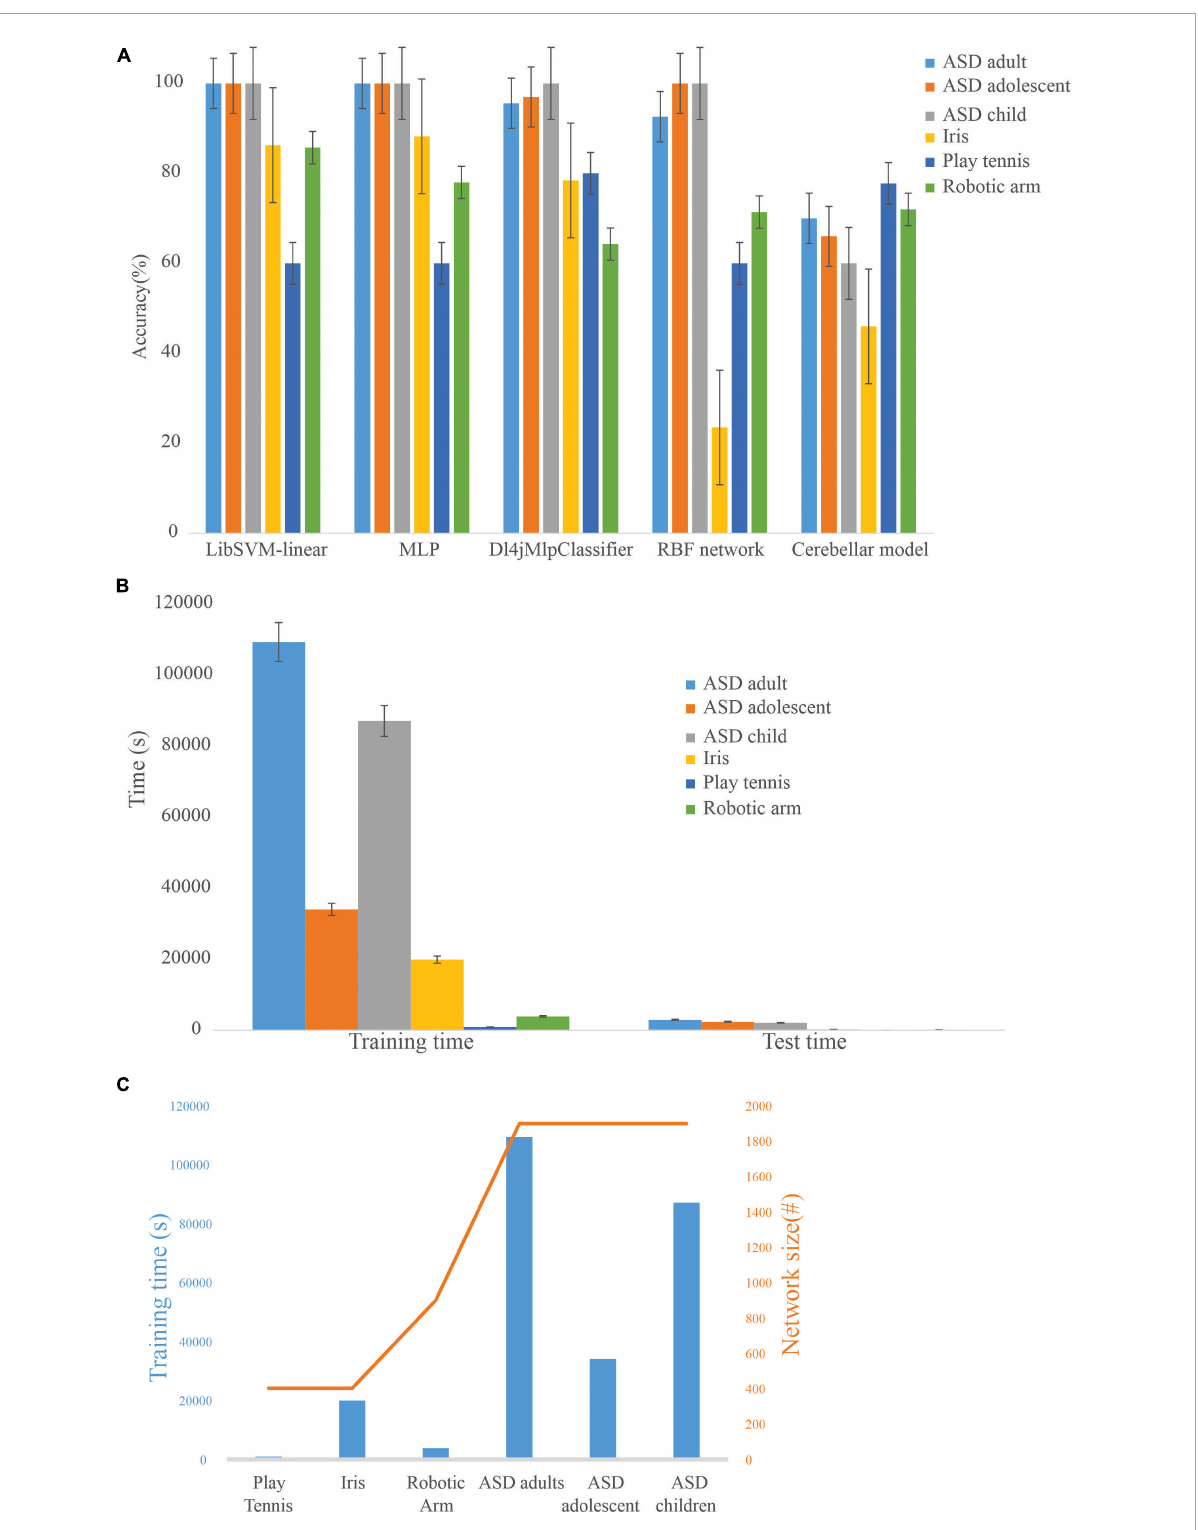
FIGURE6 Comparison of the cerebellar model with machine learning algorithms on standard datasets (A) . Training accuracy of machine learning algorithms on different datasets showed that the cerebellar model could be used on a flexible dataset and rote learning was minimized. (B) Computational time required by the cerebellar model during the training and testing phase on various datasets. (C) Dependency of network size on training